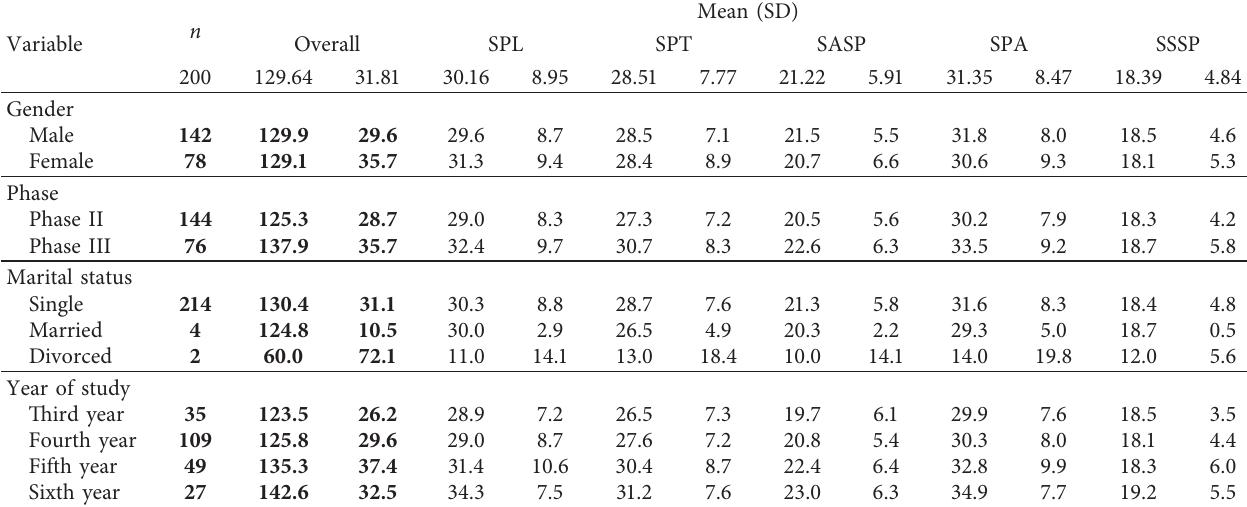
Table 4: Mean (SD) DREEM scores as per demographic characteristics of the participants.